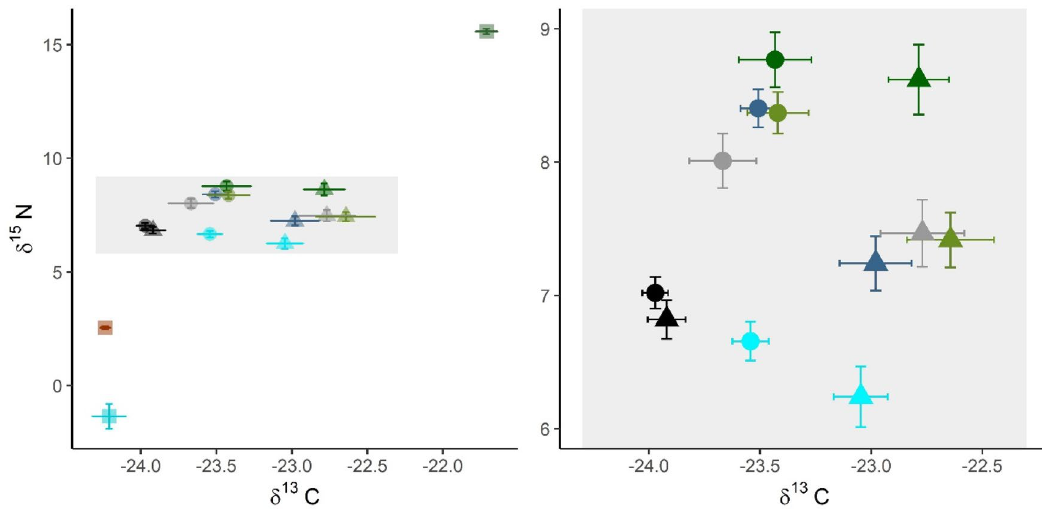
Figure 3. Stable isotope bi-plot of δ 15 N and δ 13 C values in the different components of the experimental system. Left panel: the food sources in the experimental microcosms (squares), including sediment (brown), diatoms (dark green), and cyanobacteria (turquoise), and the test animals (shaded field). Right panel: a zoom-in of the shaded field from the left panel showing the signatures of the amphipods originated from the BP (triangles) and BoS (circles) populations. The colour coding: Initials (black) and the treatments: Control (grey), HD (green), HDLC (blue), LD (olive green), LDHC (turquoise). The data are shown as group means with SE as error bars.